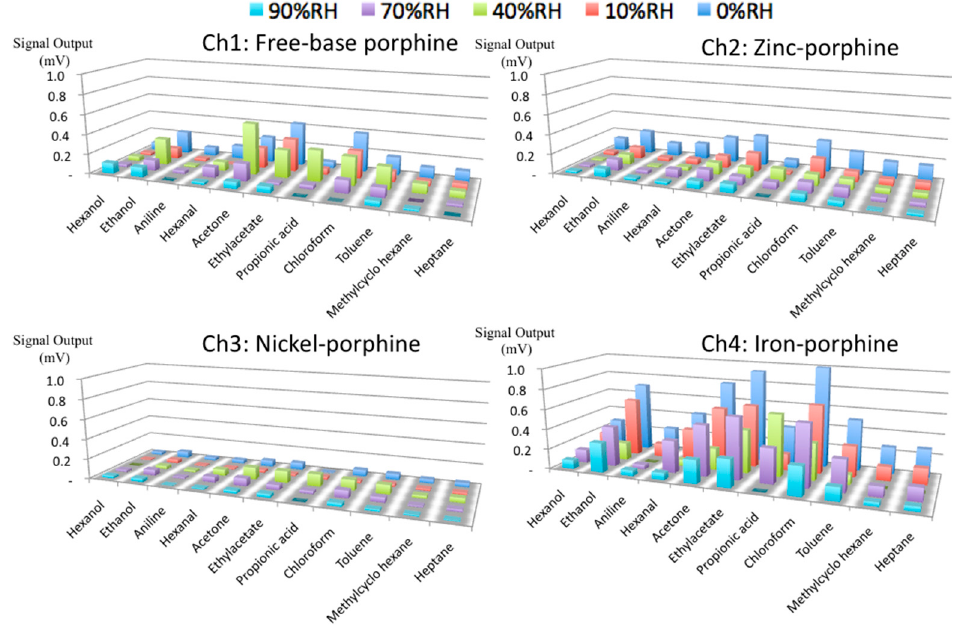
Figure 6. Sensitivity at 25 °C and 10% in partial vapor pressure at different humidity.